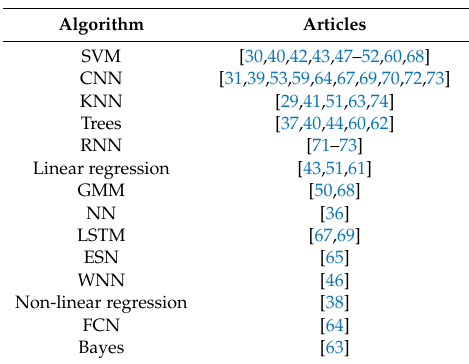
Table 3. Algorithms used in the articles